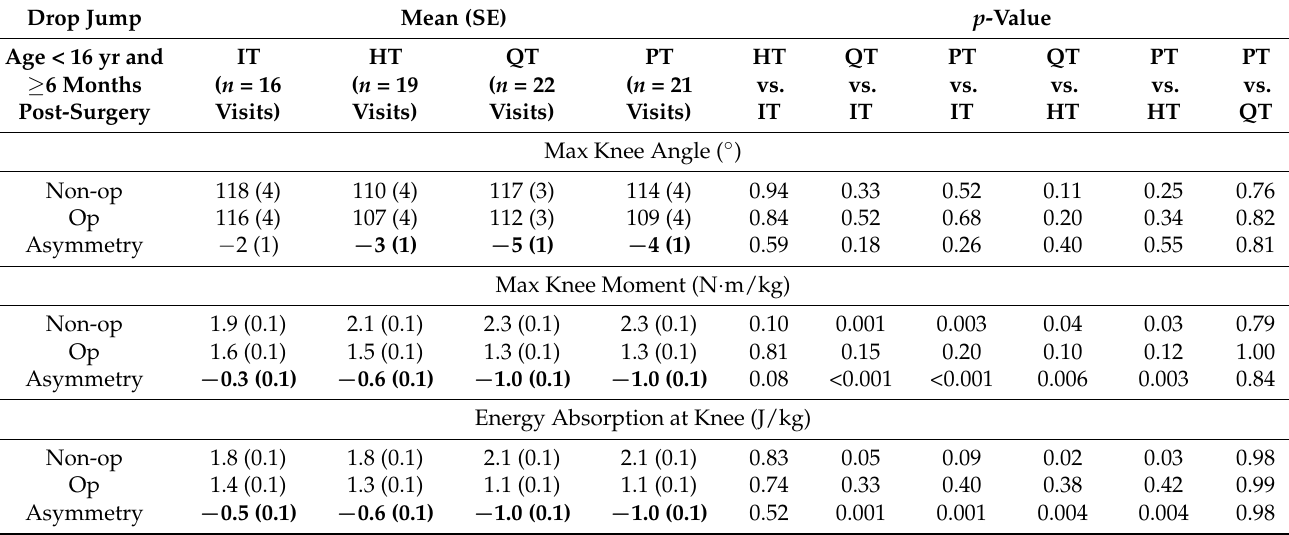
PT: patellar tendon. Table A5. Comparison of sagittal knee kinematics/kinetics for operative and non-operative limbs during vertical drop jump for patients under 16 years of age and visits at least 6 months post-surgery. Drop Jump Mean (SE) p